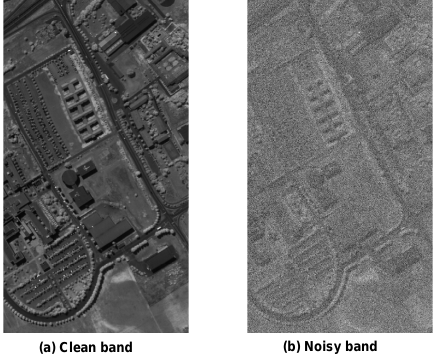
Figure 2. Pavia University bands. ( a ) clean band; ( b ) noisy band (This figure is better seen by zooming in on a computer screen).